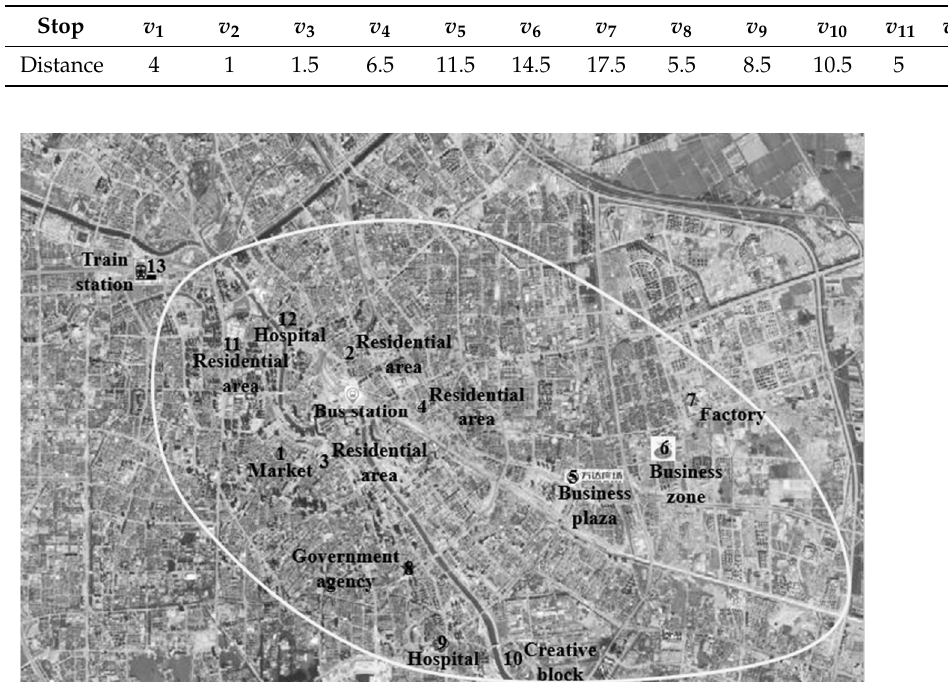
Figure 2. Layout of the customized shuttle bus service demand points. Table 1. Distance between the bus station and each stop (km).